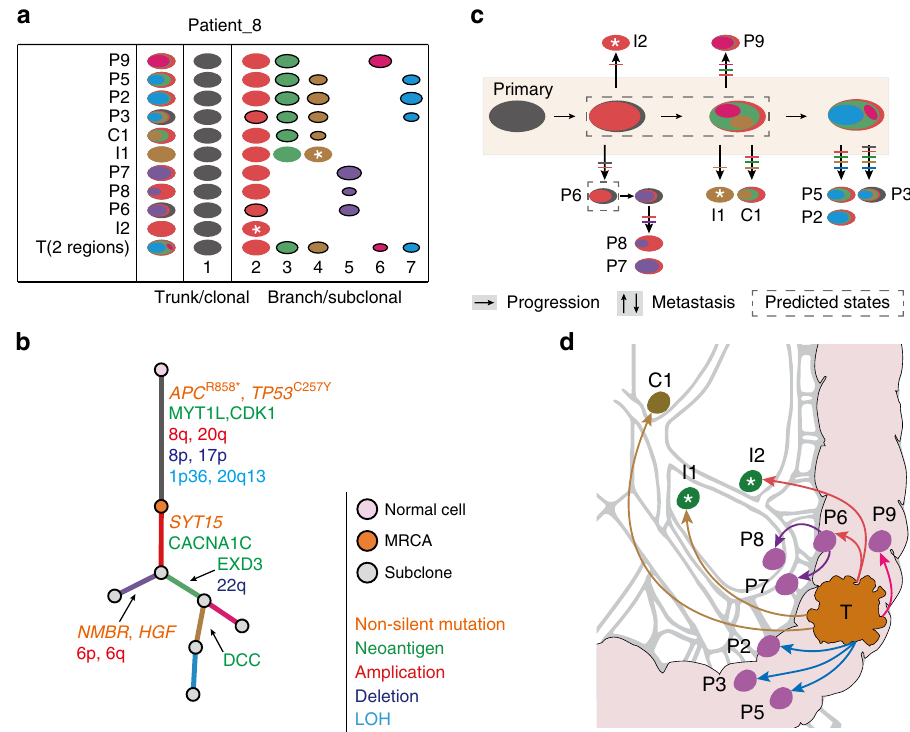
Fig. 3 Clonal evolutionary history and parsimonious metastatic map of Patient_8. a Oval plots showing the subclonal structure of tumor samples from Patient_8. Each row represents a sample. Ovals in the same color represent the same mutation clusters and are denoted by numbers. The area of each oval is proportional to its CCF value. Subclones are shown with solid borders. Subclonal structures are illustrated by the nested ovals to the left. The mutation cluster clonal in all lesions (cluster 1) is the trunk cluster, representing the most recent ancestor clone (MRCA). Other mutation clusters (clusters 2 – 7) shared by two or more lesions are de fi ned as branch clusters, representing branch subclones. White asterisks denote monoclonal metastases. b Clonal evolutionary tree inferred from the subclonal structure. Lengths of lines are proportional to the number of substitutions in each cluster. Selected aberrations are labeled accordingly. LOH, loss of heterozygosity. c Clonal evolutionary history. The dashed box shows the predicted historical states of the primary tumor. Horizontal arrows denote acquisition of new subclones and tumor progression. Vertical fi shbone-like arrows denote metastases, which are labeled with involved clone/subclones. Each colored line corresponds to a clone/subclone. d Parsimonious metastatic map based on the clonal evolutionary history. Each metastasis is colored by the smallest involved